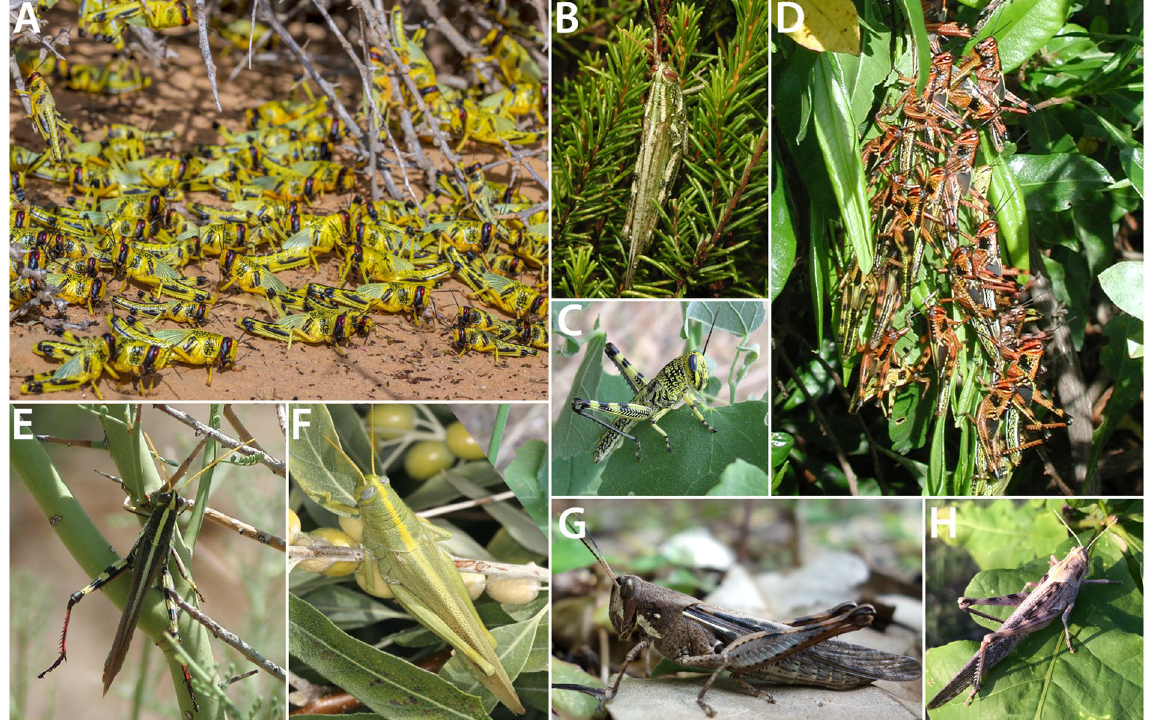
Figure 1. Some representatives of the genus Schistocerca ; ( A ) Gregarious nymphs of S. gregaria ; ( B ) S. ceratiola ; ( C ) S. lineata nymph feeding on Ptelea ; ( D ) Gregarious nymphs of S. piceifrons ; ( E ) S. albolineata ; ( F ) S. shoshone ; ( G ) S. caribbeana ; ( H ) S. nitens (Photo credit: Gil Wizen [ A ], Hojun Song [ B–H